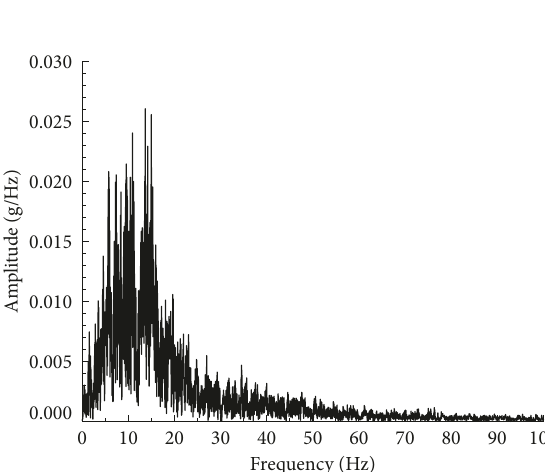
Figure 4: Fourier spectrum of Wenchuan seismic wave.